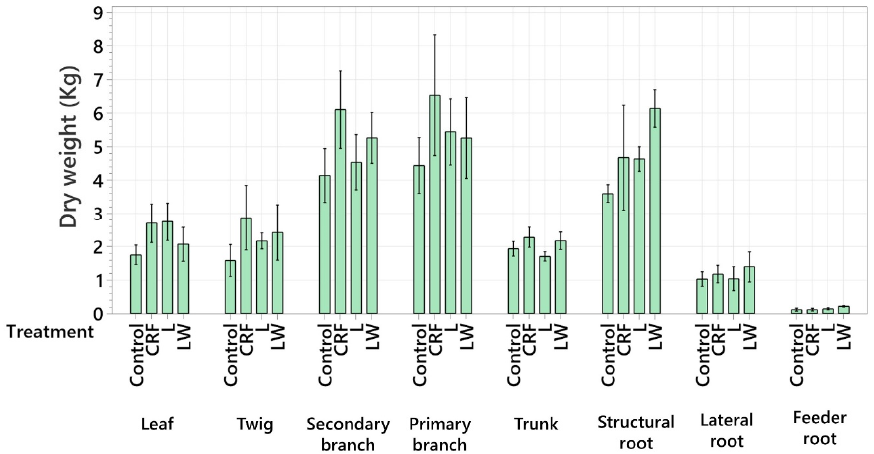
Figure 5. Dry weight (kg) of each tree component. Six-year-old Huanglongbing-affected ‘Ruby Red’